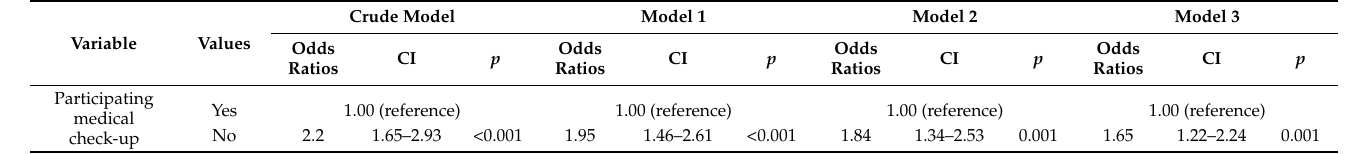
Table 3. The ORs (95% CIs) of new-onset of depressive symptoms by participating in medical check-ups among the elderly population in the logistic regression